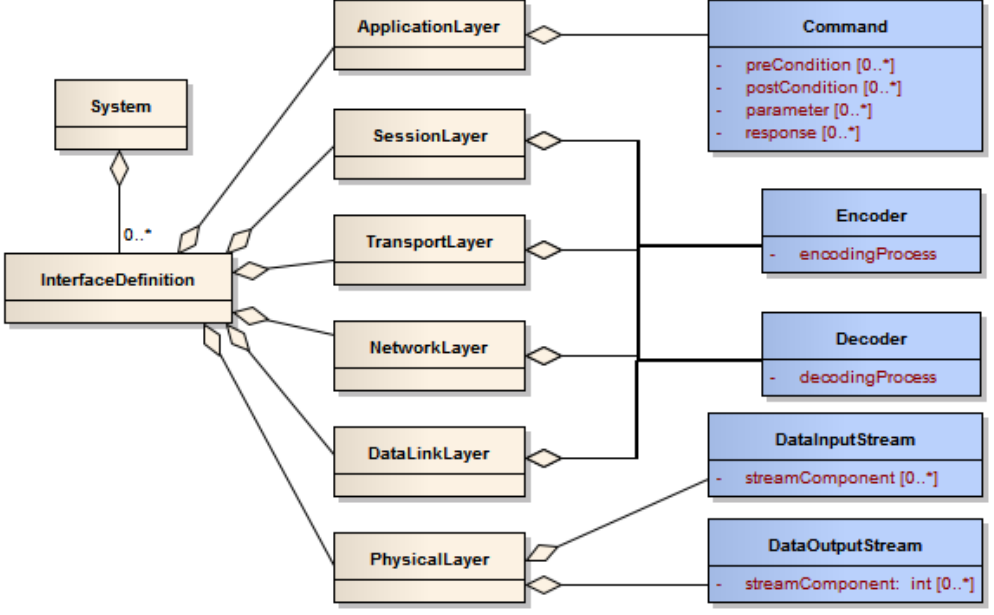
Figure 8. Overview of SID extension to